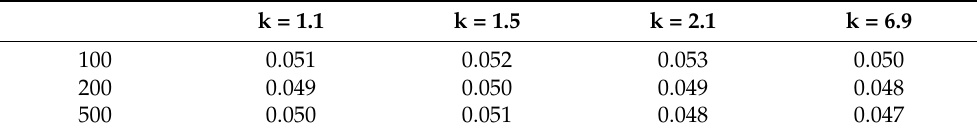
Table 4. Critical values for the two step intercept and trend